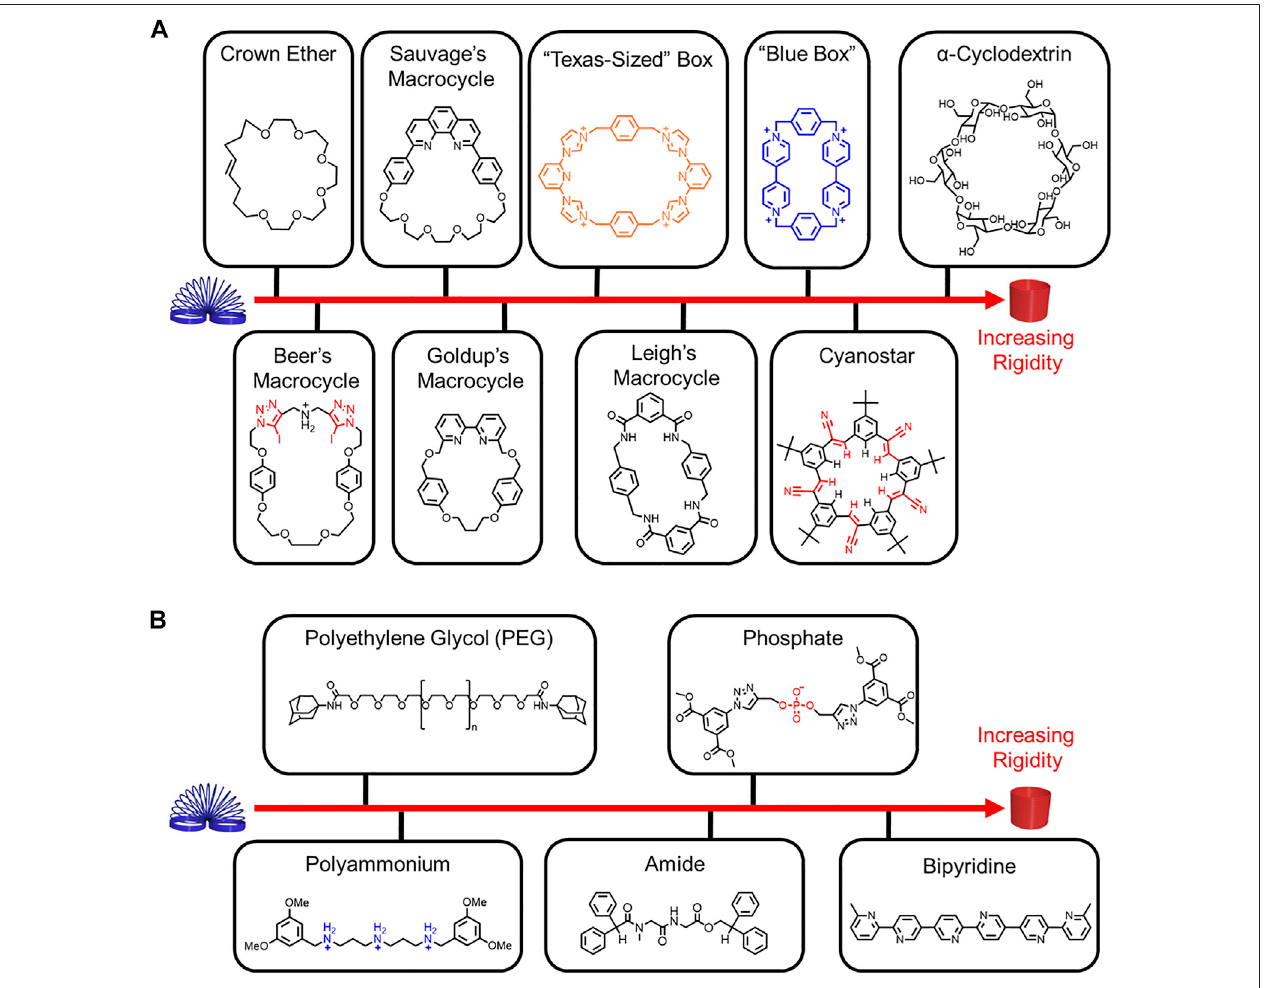
FIGURE 2 | Relative rigidity of representative (A) macrocycles and (B)